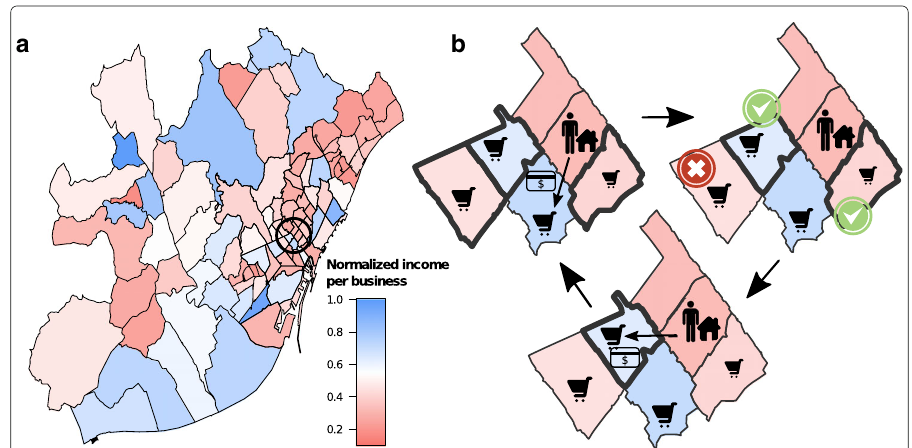
Fig. 1 Rewiring urban shopping trips. a Average income per business in the neighborhoods of Barcelona resulting from individual transactions. The average income has been normalized by the maximum value among neighborhoods. The data correspond to 2011 and is displayed by zip code in the metropolitan area. From this perspective, some neighborhoods are five times richer than others. b The general principle common to the iterative rewiring methods. At each step a transaction is randomly selected, along with the possible alternative businesses ( highlightedinbold ). If rewiring the transaction to one of them (randomly selected) decreases inequality between neighborhoods and matches the other constraints, then rewiring is